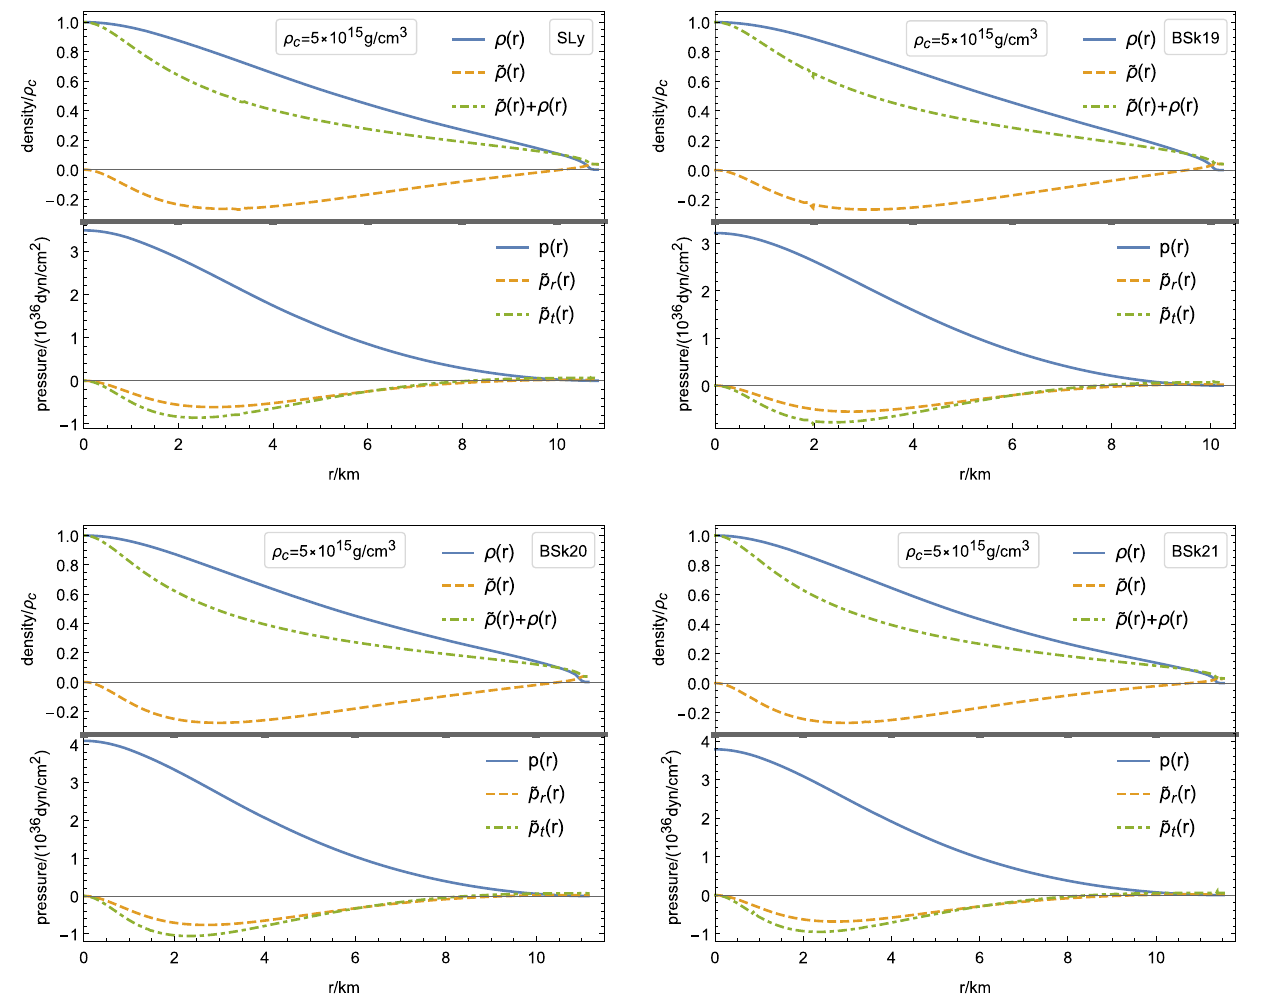
Fig. 5 Density and pressure profiles for SLy, BSk19, BSk20, and BSk21 EOSs with α = − 10 r 2 g and ρ c = 5 . 0 × 10 15 g / cm 3 . The radii of the NSs are 10 . 86km , 10 . 24km , 11 . 15km, and 11 . 53km,